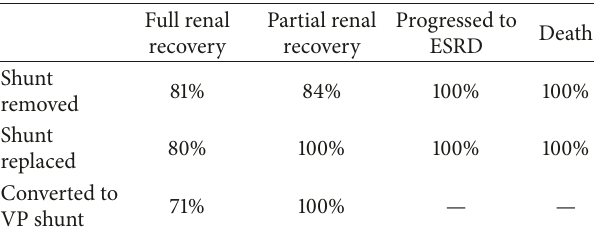
Table 9: Proportion of patients that received concurrent antibiotic therapy.